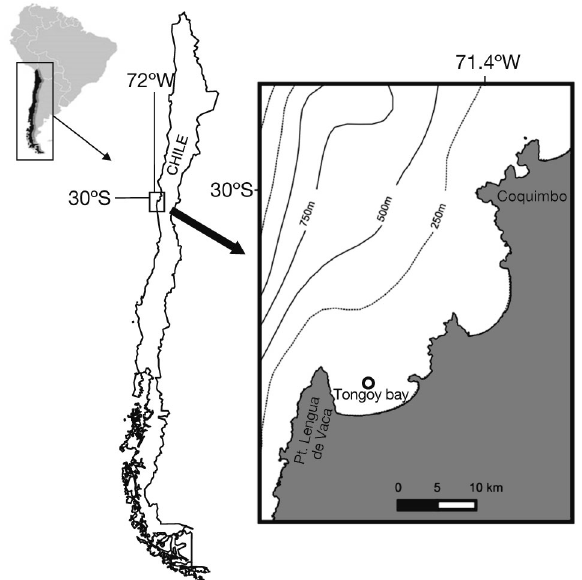
Fig. 2. Geographic location of Tongoy Bay and Pt. Lengua de Vaca upwelling center. The circle indicates the location of the CEAZAMET buoy, which is moored adjacent to the aquaculture facilities of the Invertec−Ostimar aquaculture